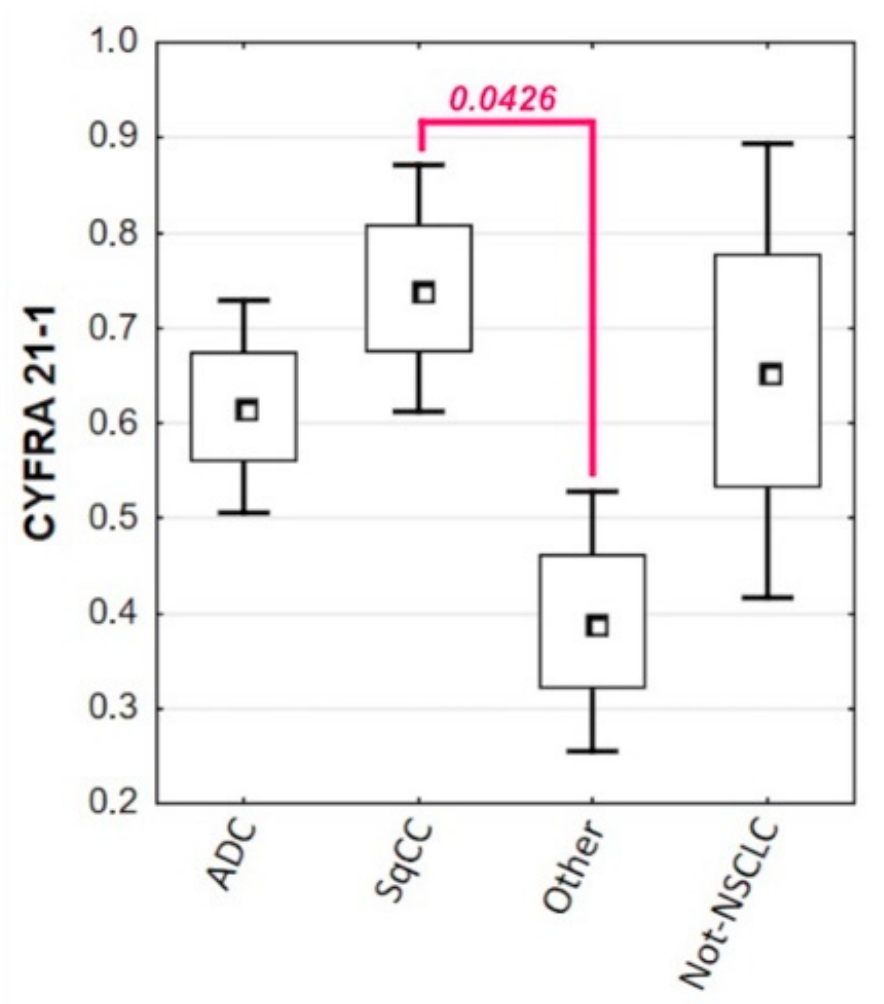
Figure 2. Distribution of CYFRA 21-1 levels in lung cancer subtypes with the statistically significant difference between patients with SqCC and other NSCLCs ( p = 0.0426).